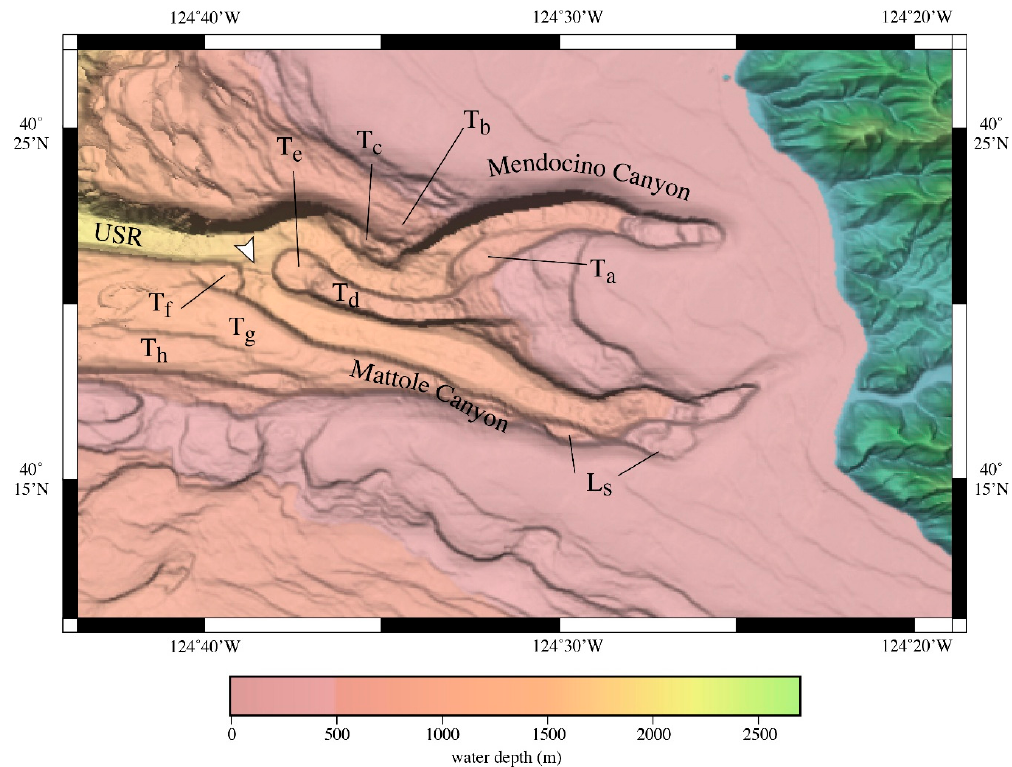
Figure 6. Map view of NOAA Coastal Relief Model bathymetry of Mendocino and Mattole Canyons. Features labeled T x are 6 individual terraces (see discussion in text) and white arrowhead is an 80 m step-down of the floor of Mattole Channel to the floor of Mendocino Channel at the capture point. L s points to two scarps on the wall of Mattole Canyon. USR is Upper Straight Reach of Mendocino Channel. See Figure 2 for location.